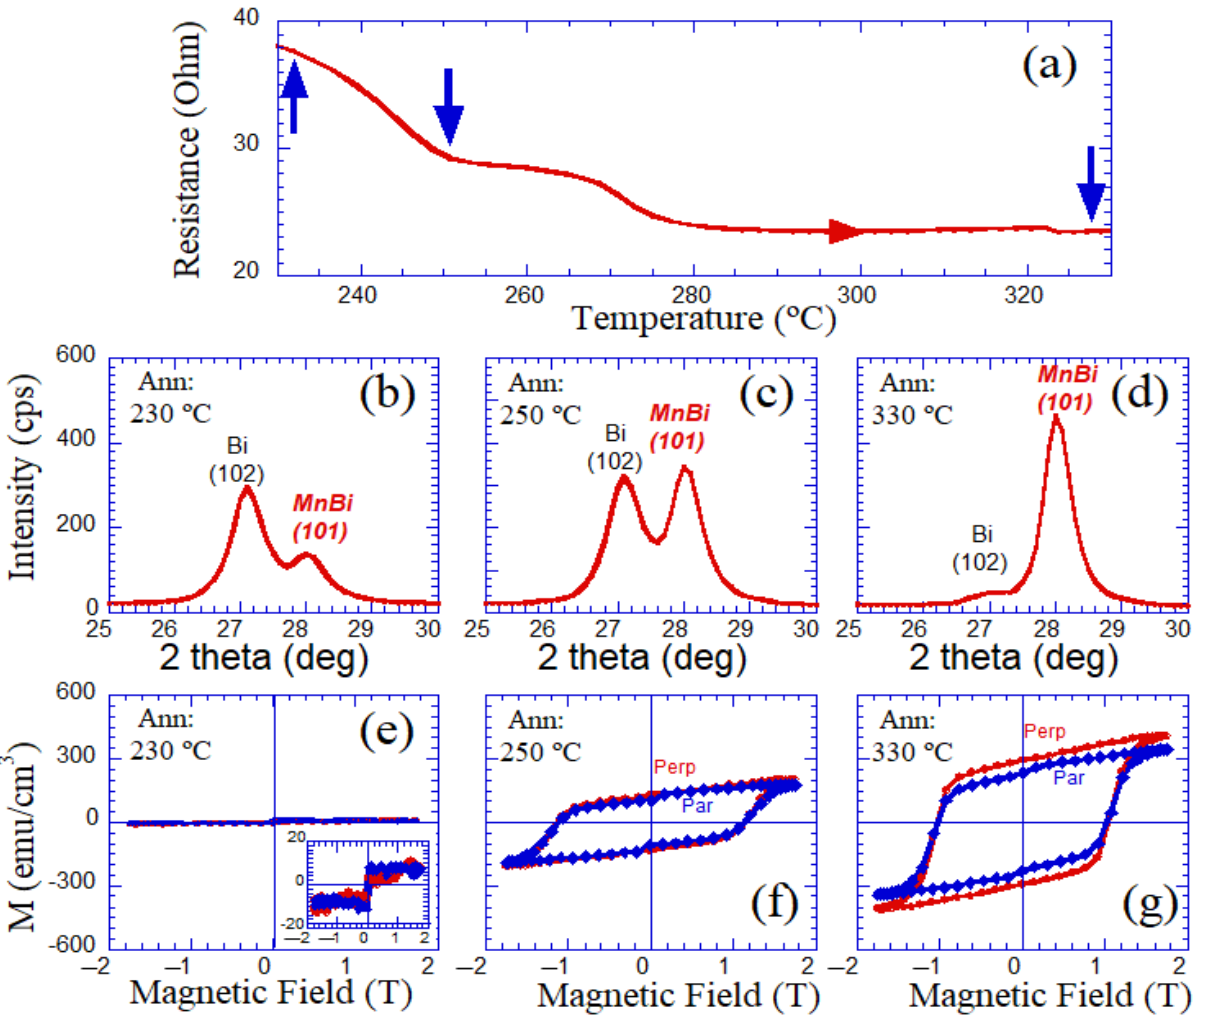
Figure 5. Resistance as a function of the temperature of the Mn(55%)Bi(45%) sample ( a ). The blue arrows over the resistance curve indicate the annealing temperatures. The red arrow indicates that the resistance was measured on increasing the temperature. X-ray diffraction patterns ( b – d ) and room-temperature magnetic hysteresis loops ( e – g ) of the 230, 250 and 330 °C annealed Bi(45%)Mn(55%) samples, respectively. The inset of Figure ( e ) shows the enlarged magnetization curves of the sample. Par and Perp indicate the parallel and perpendicular orientation of the magnetic field with respect to the film plane.